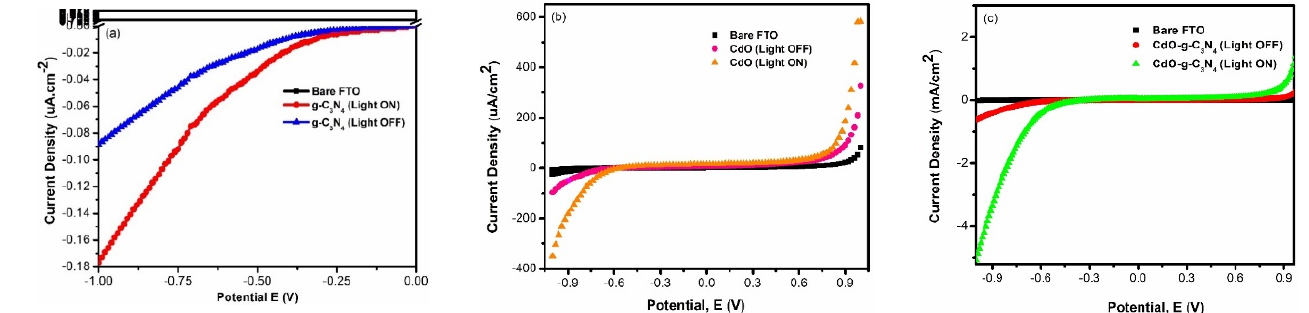
Figure 7. Linear Sweep Voltammetry pro fi le in applied potential range of − 1 V to 1 V, at a scan rate of 100 mV/s in 0.5 M Na 2 SO 4 aqueous solution ( a ) g-C 3 N 4 nanosheets ( b ) CdO -nanorods and ( c ) CdO-g-C 3 N 4 nanocomposite in a three-electrode system under 1 Sun light irradiation in an OFF and ON light mode.